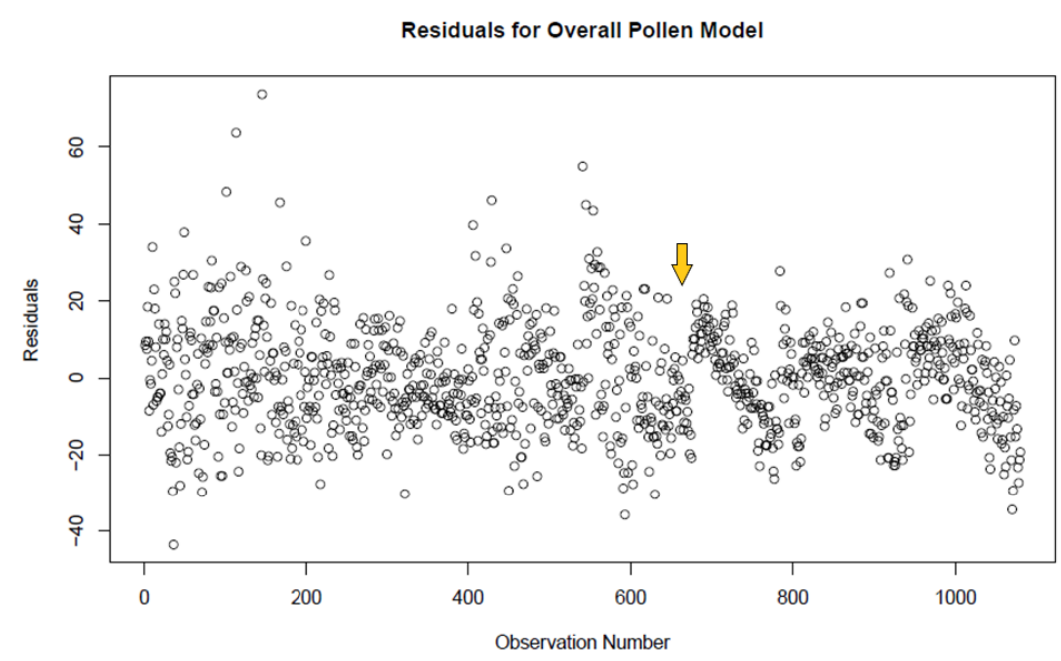
Table 1. Summary of the overall analysis of variance.